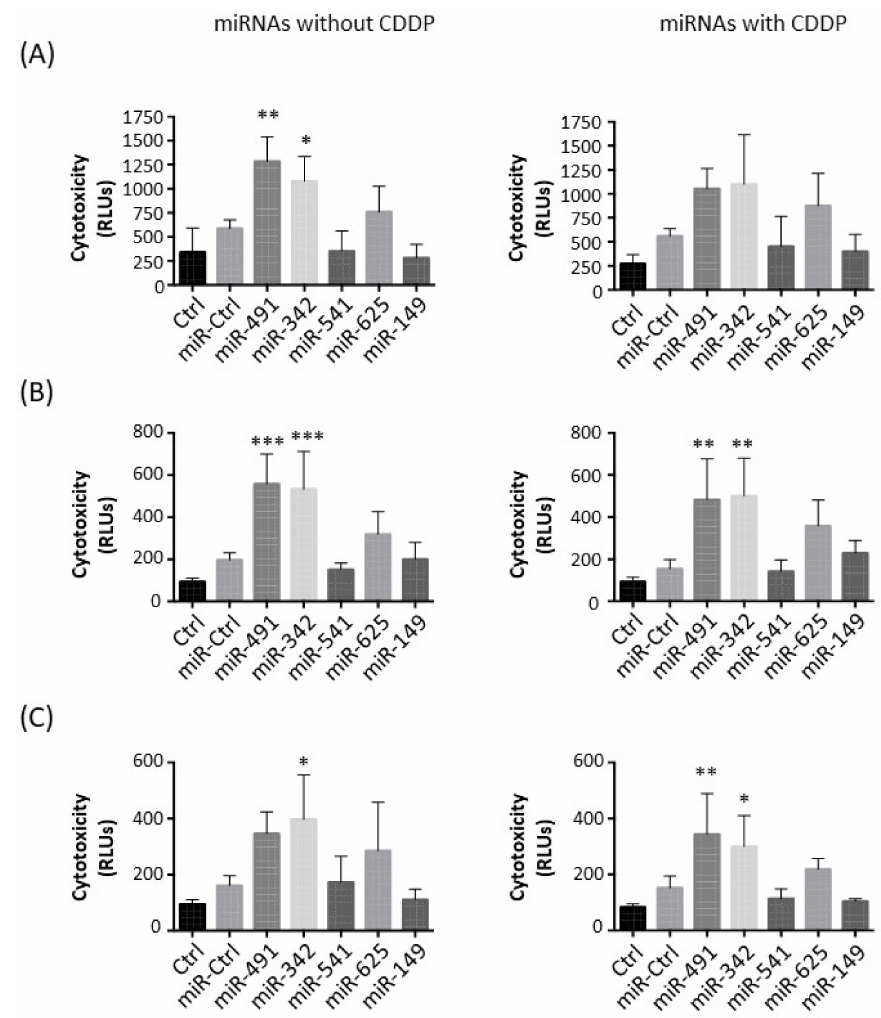
Figure 2. Evaluation of miRNA-induced cytotoxicity on osteosarcoma cell lines. ( A ) HOS, ( B ) MG-63 and ( C ) SaOS-2 cells were cultured and transfected with miRNAs as described in Figure 1. The cytotoxicity of miRNAs was measured 72 h after transfection. Data are presented as the mean relative luciferase units (RLU) ± SD of four independent experiments. Statistically significant differences between miR-Ctrl and miRNA-treated cells were determined using one-way ANOVA (***: p < 0.001, **: p < 0.01, *: p <